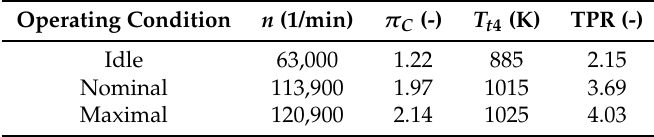
Table 1. Main parameters of PD-60R micro turbojet engine.